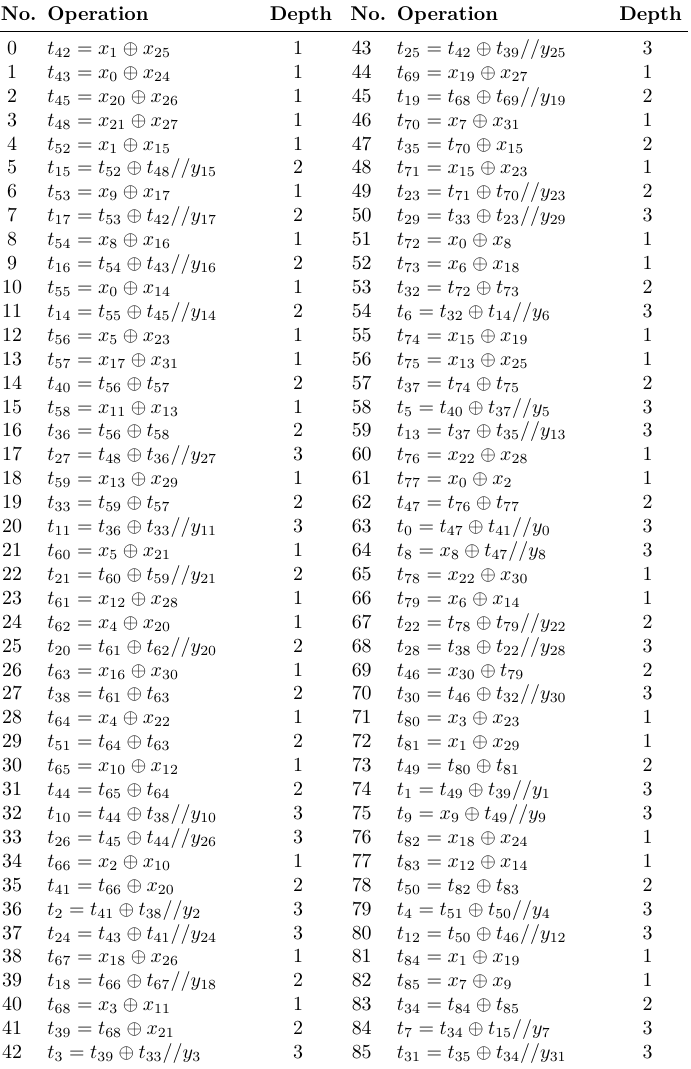
Table 10: The implementation of R with 86 XOR operations and depth of